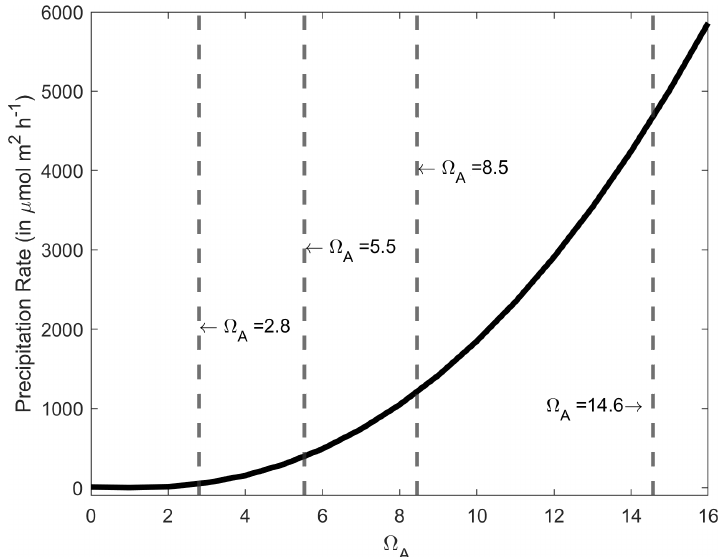
Figure A4. CaCO 3 precipitation rate onto aragonite seed crystals in µmolm − 2 h − 1 as a function of (cid:127) A , based on the measurements of Zhong and Mucci (1989) at 25 ◦ C and for a salinity of 35. The (cid:127) A values for the starting conditions and following a + 250, + 500 and + 1000µmolkg − 1 TA increase are presented by the dashed grey lines, i.e. 2.8, 5.5, 8.5 and 14.6, respectively.